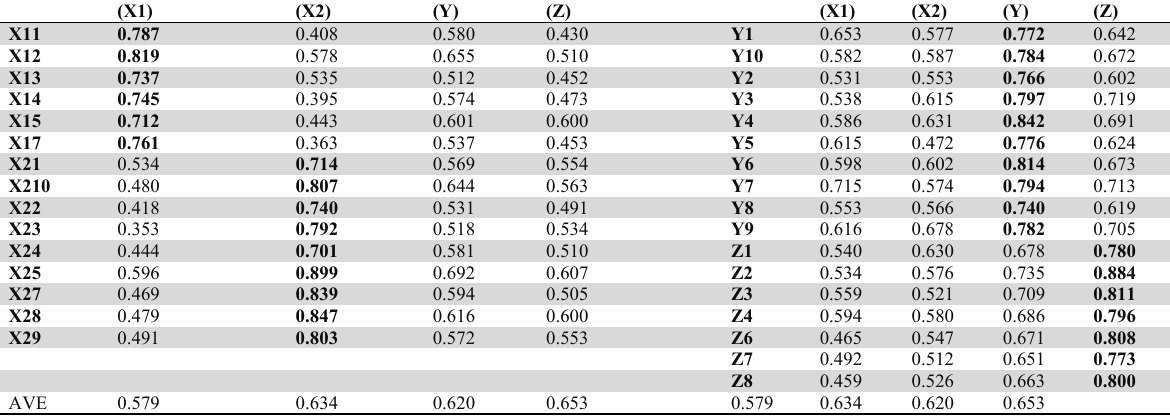
Average Variance Extracted (AVE) s and Cross-Loadings Test Results